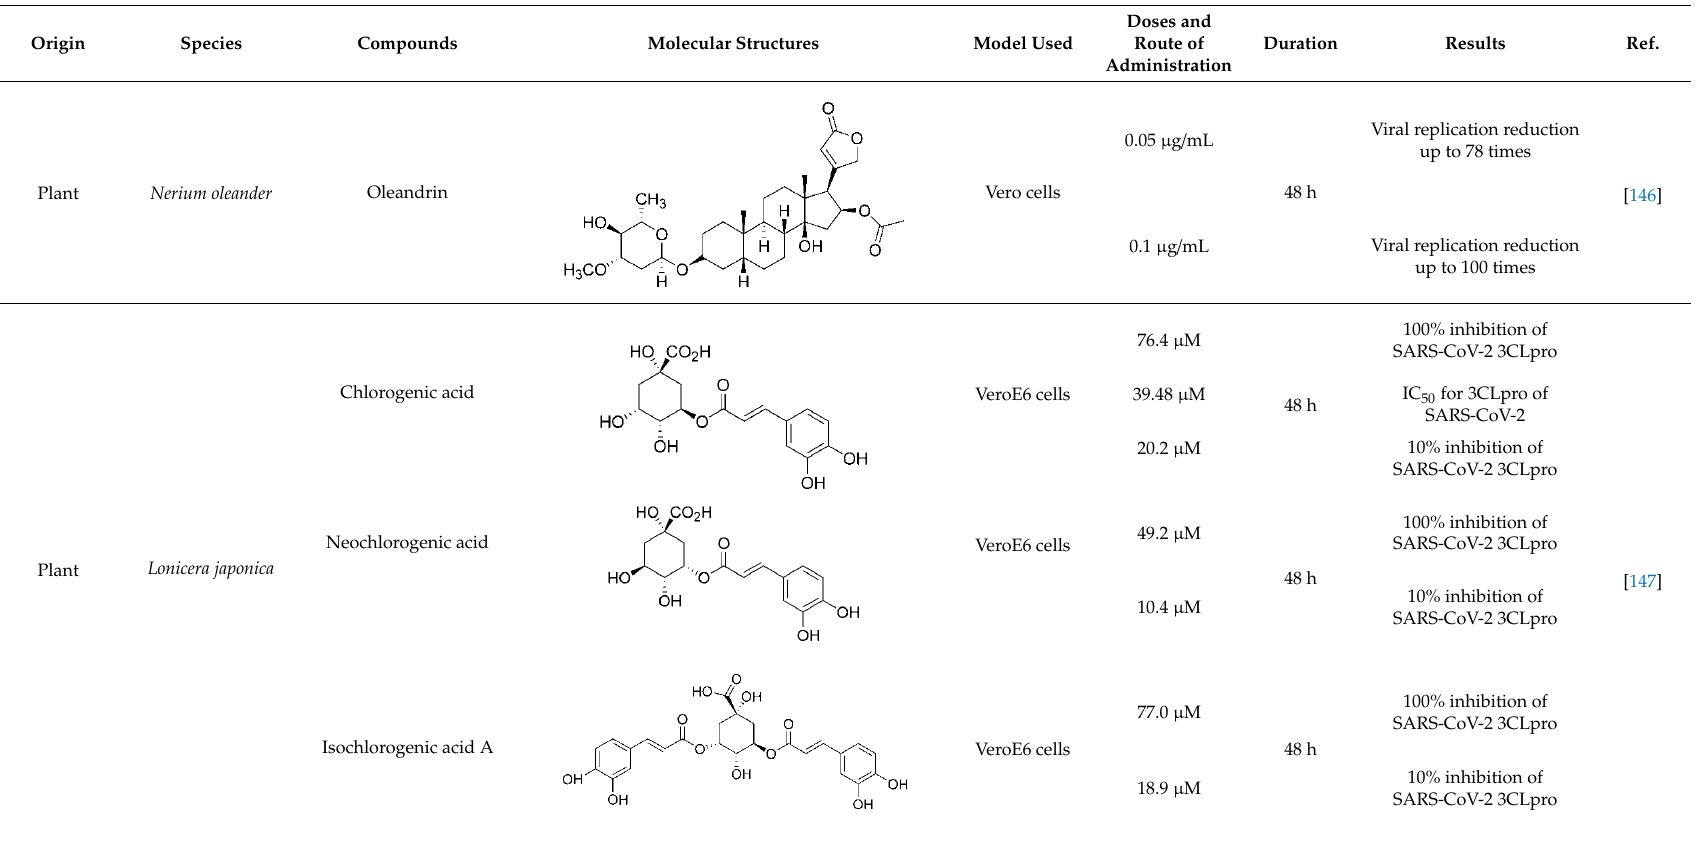
Table 1. Compounds of natural origin with anti-SARS-CoV-2 activity.